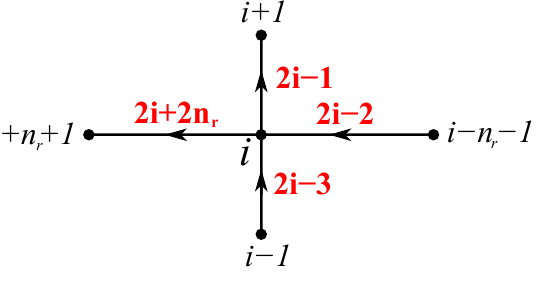
Figure 4. Node- and branch-numbering rule.